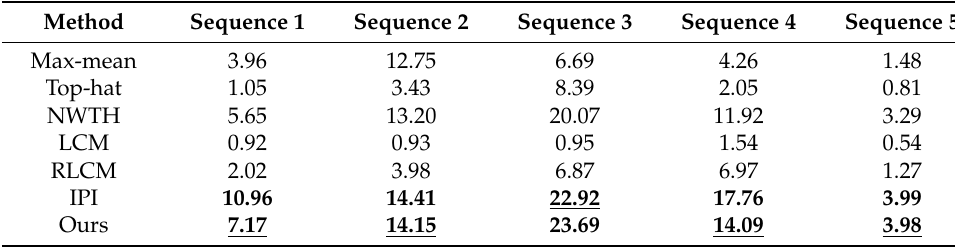
Table 4. Average BSF (notation: best result, second-best result).